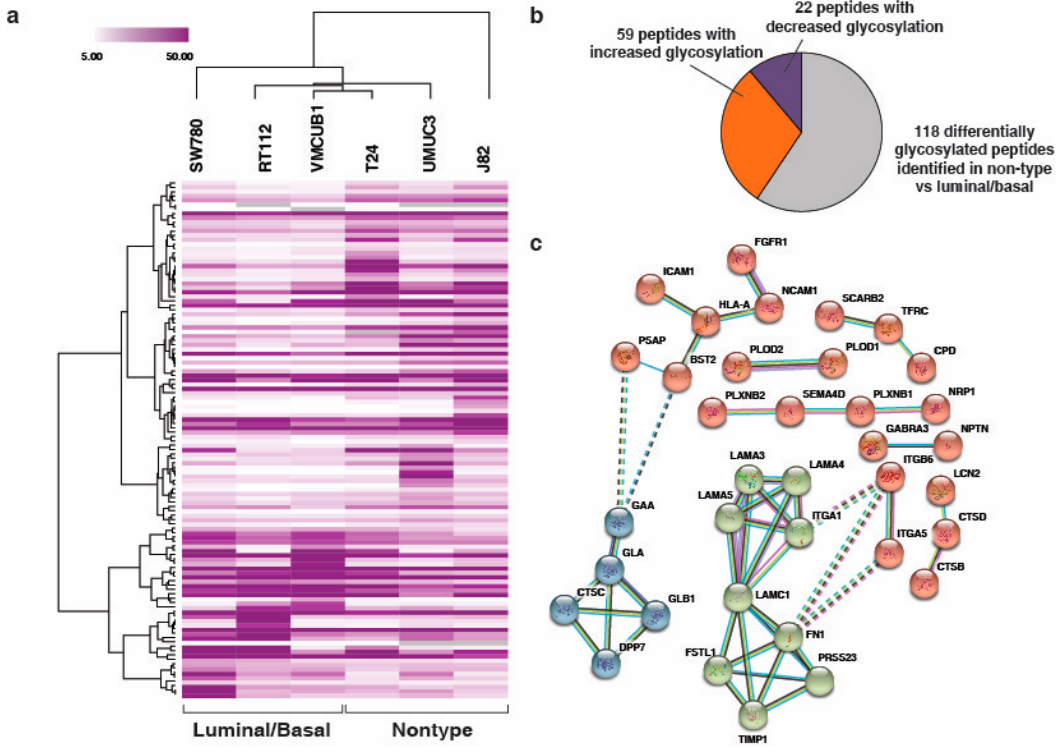
Figure 3. ( a ) Supervised clustering of the molecular subtypes of bladder carcinoma cell lines. A t -test was conducted on the glycoproteomic data that identified 118 N-linked glycopeptides (corresponding to 84 proteins) which were differentially glycosylated in the non-type cell lines (T24, J82, and UMUC3) as compared with the luminal/basal subtype (SW780, RT112, and VMCUB-1) ( p ≤ 0.05); ( b ) pie chart depicting the number of N-linked glycopeptides which depicts increased and decreased glycosylation in the non-type cell lines ( p < 0.05); ( c ) protein–protein interaction network enriched in the non-type cells with highest confidence (0.90) acquired using STRING functional protein association network tool.